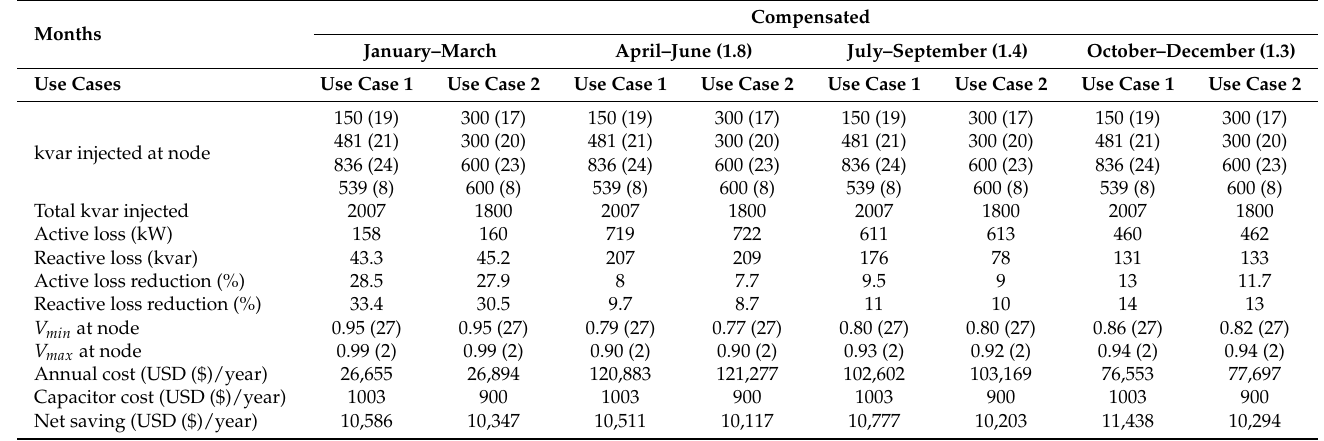
Table 6. Results comparison of N 1 for CS 2 (Scenario 1).